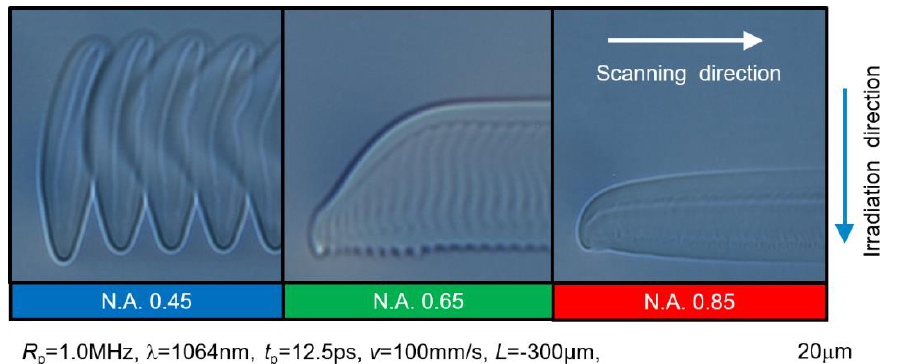
Figure 16. Influence of Numerical Aperture on Shape of Molten Area.